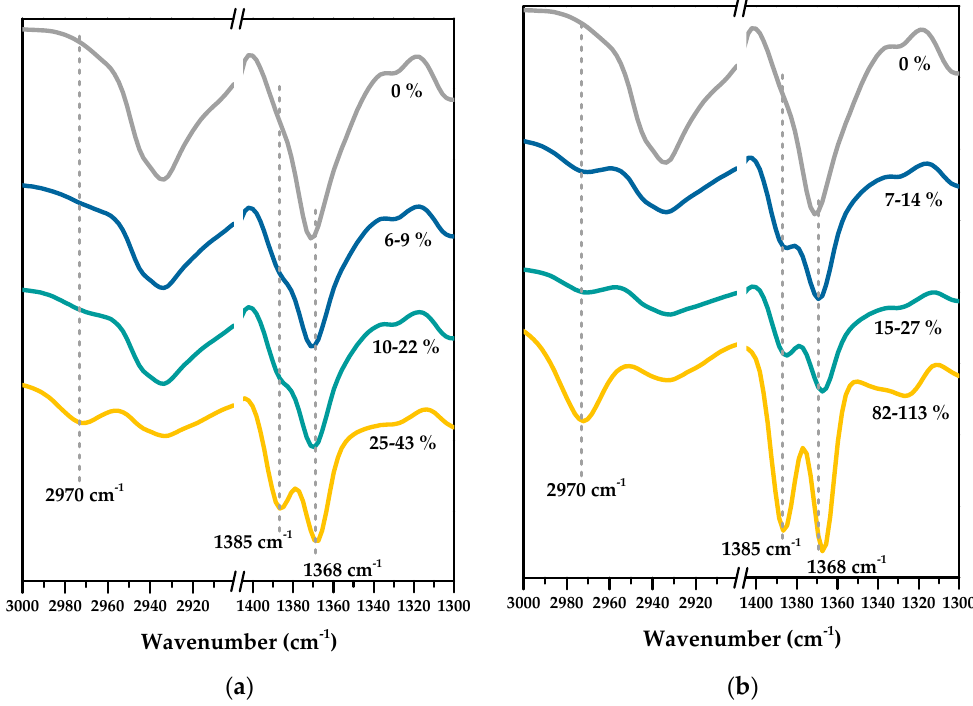
Figure 2 . ATR - FTIR spectra of PNIPAm - grafted nylon membranes with different grafted yields Figure 2. ATR-FTIR spectra of PNIPAm-grafted nylon membranes with different grafted yields for: for : ( a ) linear; ( b ) c rosslinked structures . ( a ) linear; ( b ) crosslinked